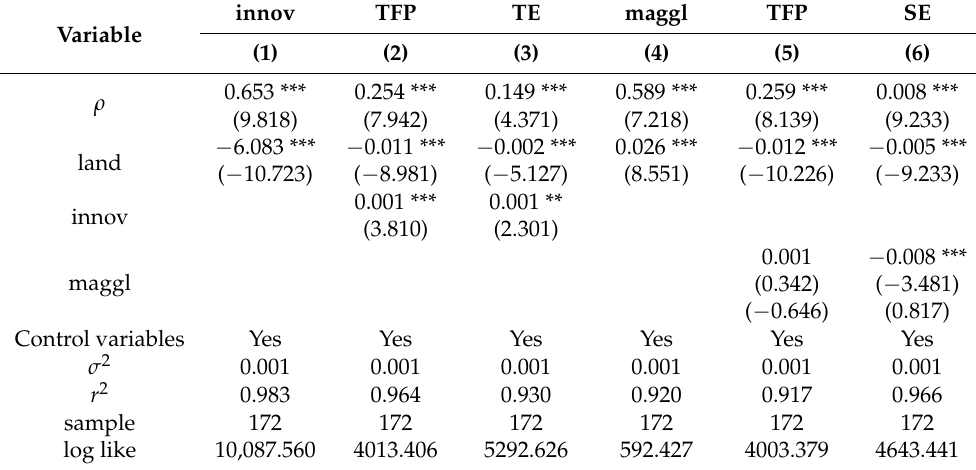
Table 8. Test of influence mechanism in the central and western